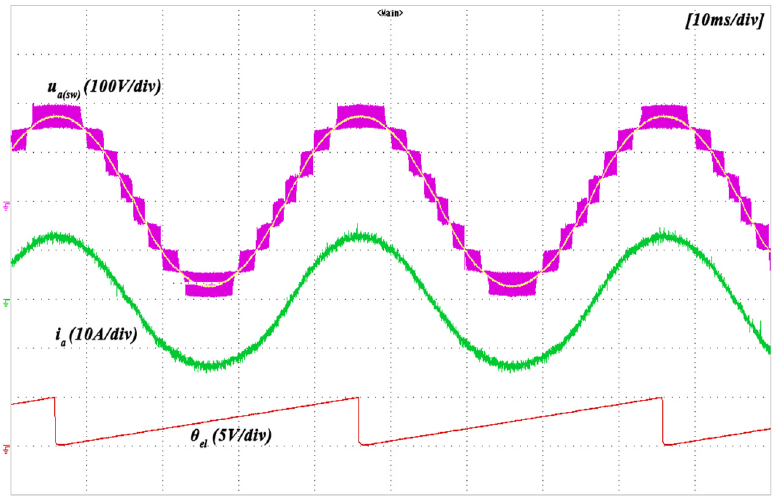
Figure 22. 3 Φ 5L E-Type MMR waveforms, from top to bottom: phase-to-neutral switching voltage u a(sw) , fundamental component (extracted), electrical machine phase current i a , and angular position θ el .